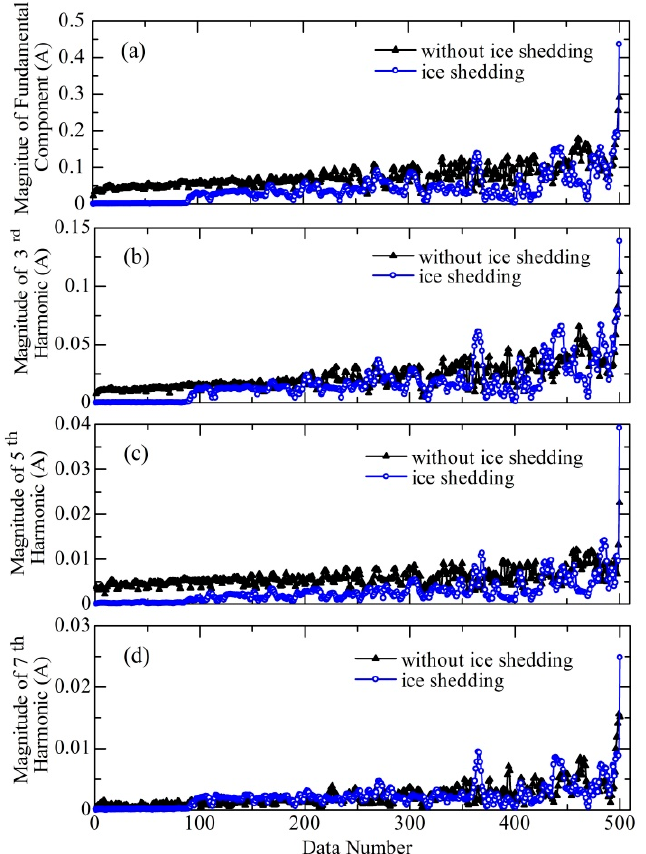
Figure 5. Temporal variation of different LC components during the flashover process of ice-covered insulators with and without ice shedding: ( a ) fundamental component; ( b ) 3rd harmonics; ( c ) 5th harmonics; ( d ) 7th harmonics.